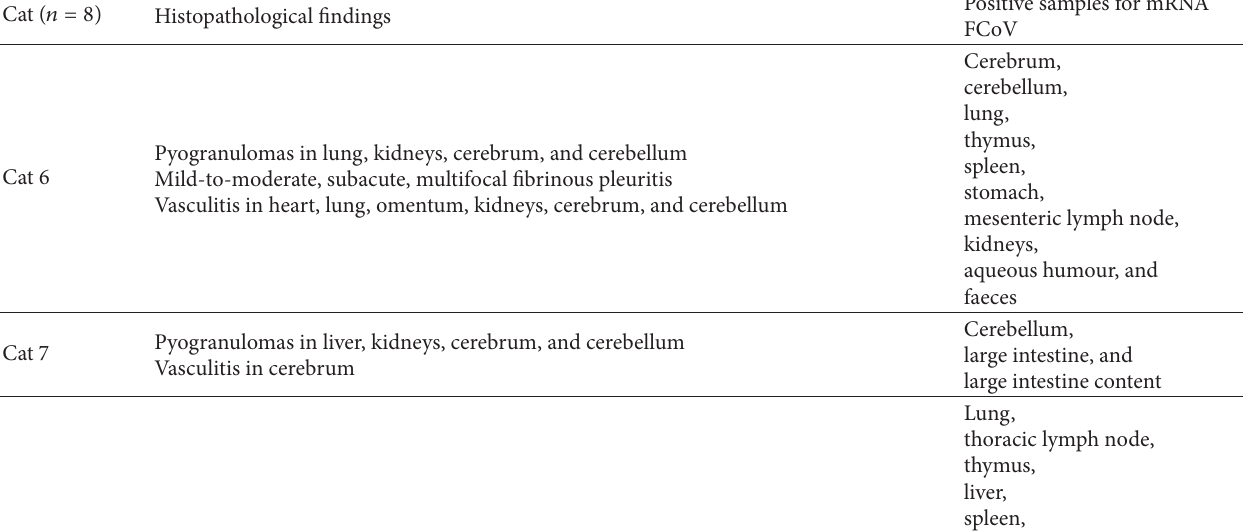
Table 2: Histopathological analysis and results of FCoV mRNA RT-PCR in diseased cats with FIP. Cat ( 𝑛 = 8 ) Histopathological